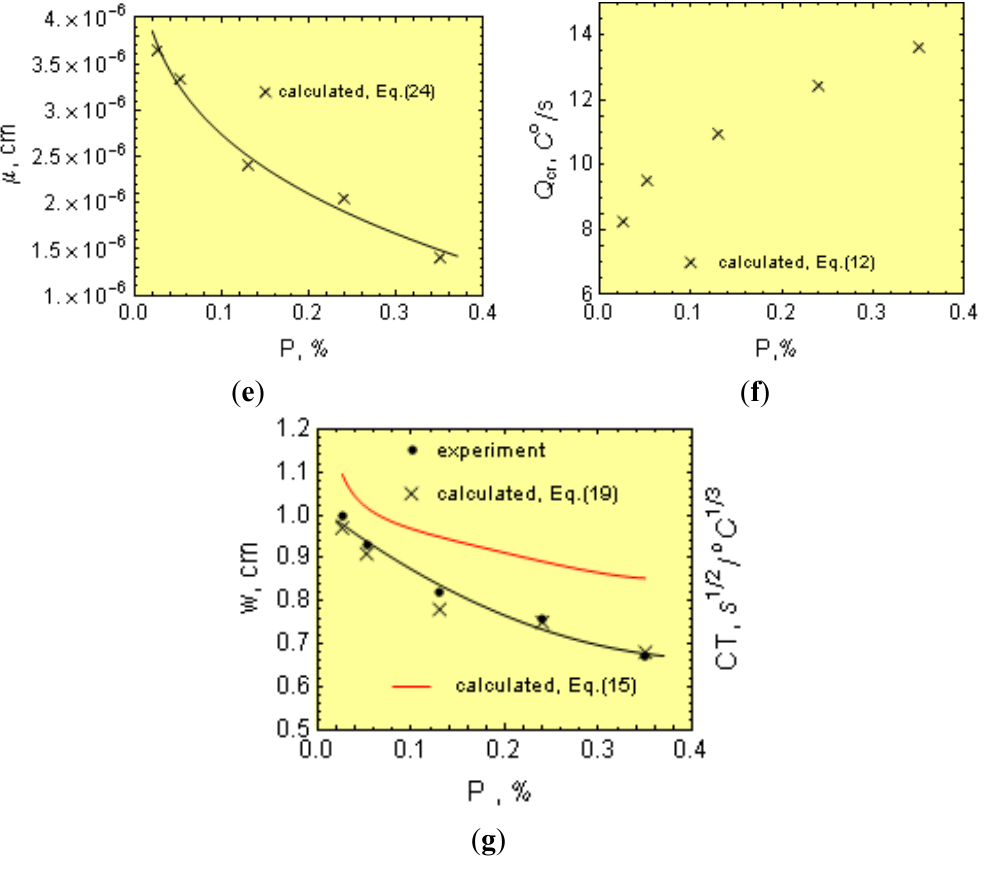
Figure 20. Effect of phosphorous on ( a ) N s , ( b ) b , ( c ) f , ( d )  T sc , ( e ) μ, ( f ) Q cr and ( g ) w. The phosphorous intensity effect on the CT index through f, μ  T sc , N s and b is shown in Figure 21.